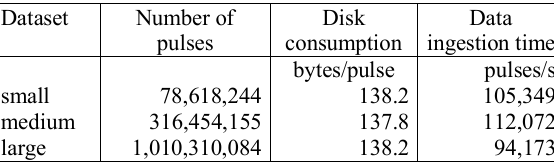
Table 1. Data ingestion costs